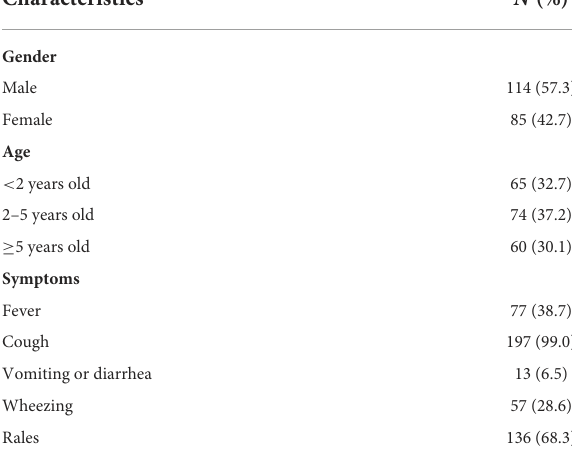
TABLE 2 Demographic information and basic clinical features of the